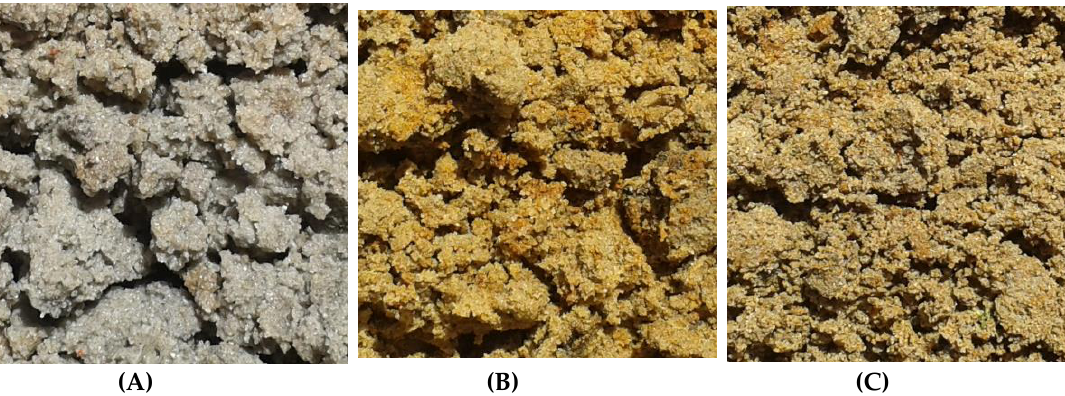
Figure 12. Soil samples from the 10 cm layer directly at nonwoven geotextile: ( a ) zone A upstream of drainage, ( b ) zone B above drainage, ( c ) zone C downstream of drainage.